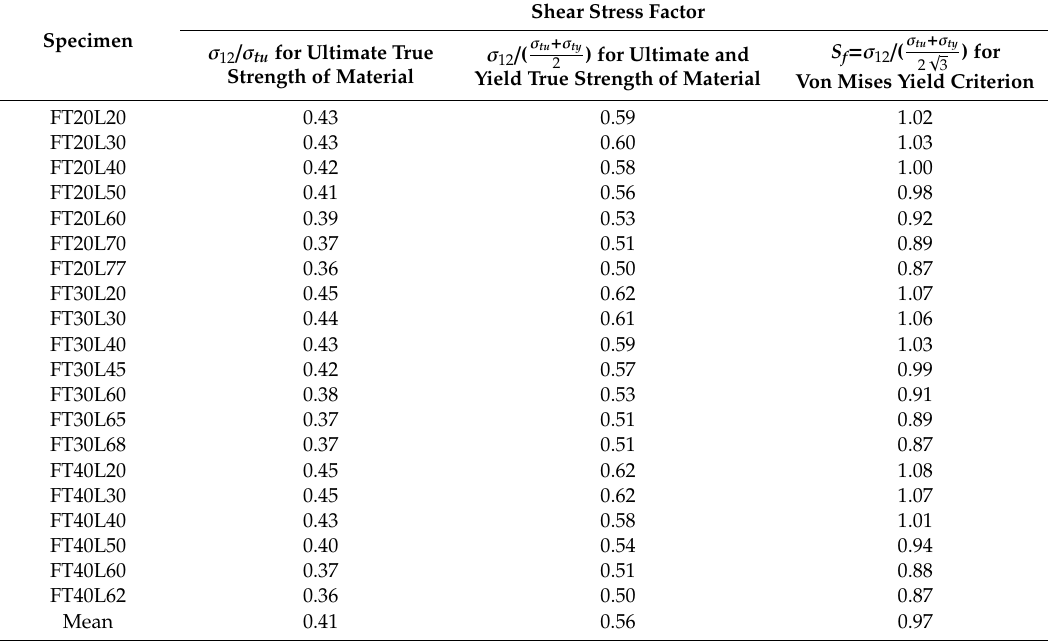
Table 7. Proposed stress factors for specimens with block shear fracture by parametric analysis results.